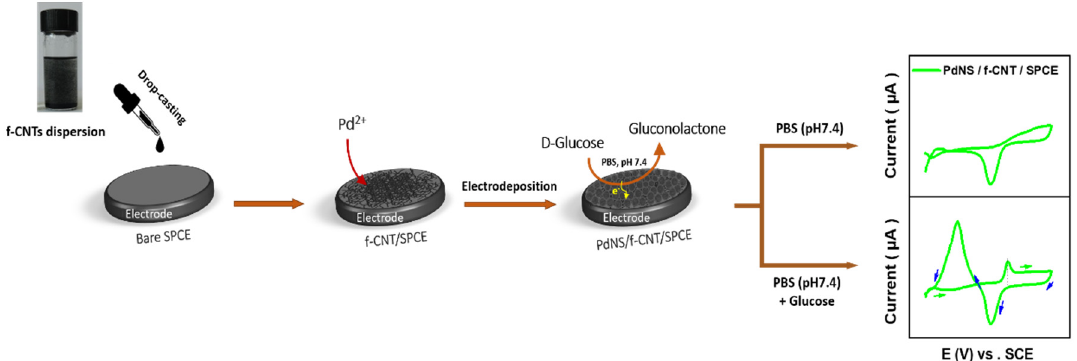
Figure 1. Schematic illustration of the preparation procedure of PdNS/f-CNT/SPCE and the experi- mental setup used for the CV measurements performed in 0.1 M PBS (pH 7.4), with and without glucose molecules.